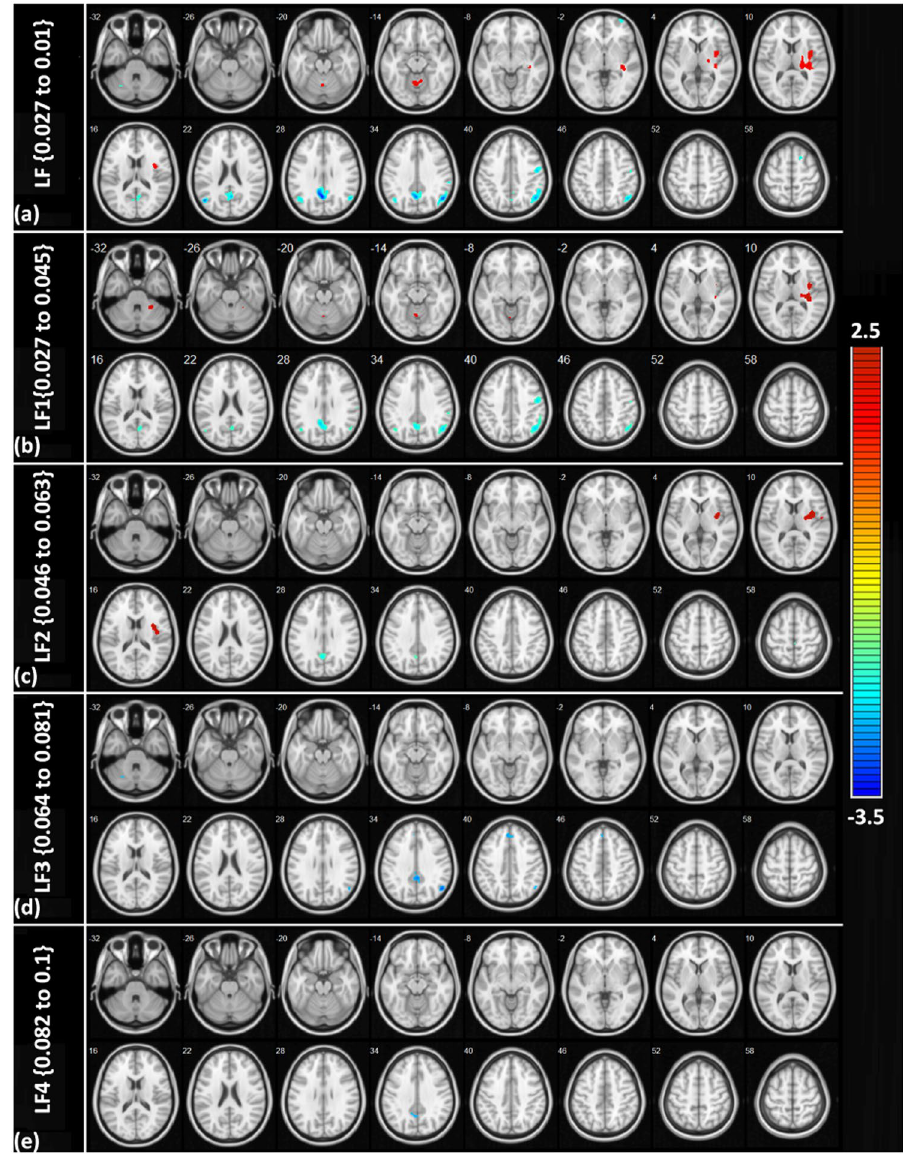
Figure 6. Multiband functional connectivity analysis. Rows “a to e” represent the images of the regions which showed significant differences in the DLC between baseline and sedated states. ( a ) represents the entire frequency range {0.027to 1 Hz}, ( b ) is LF1{0.027 to 0.045 Hz}, ( c ) is LF2 {0.046 to 0.063 Hz} ( d ) is LF3 {0.064 to 0.081 Hz} and ( e ) is LF4 {0.082 to 1 Hz}. It is evident that the deep nuclear regions depicted as red is only seen in rows b and c indicating a frequency range between 0.027 to 0.063